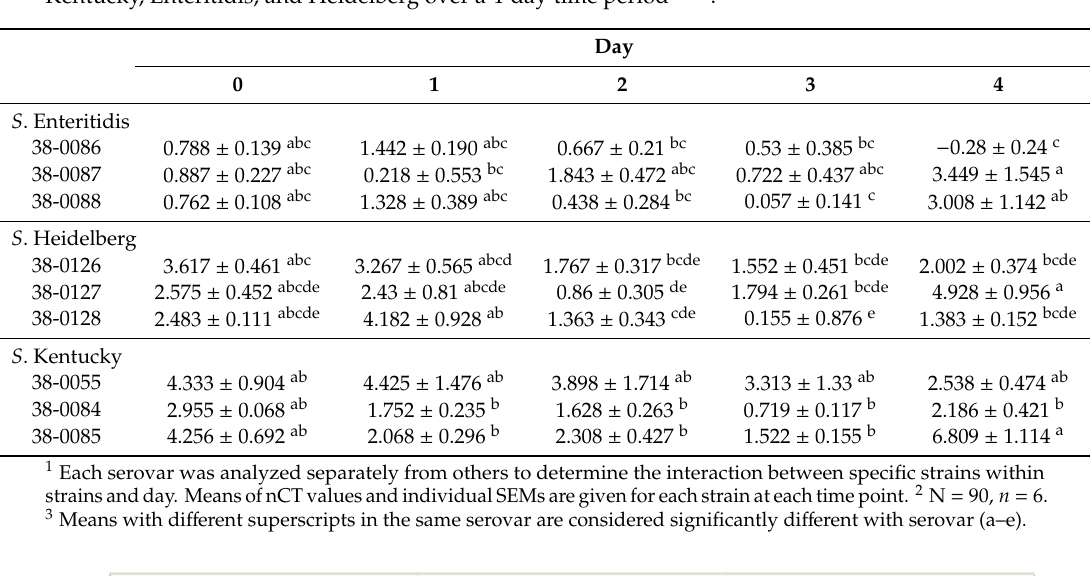
Table 2. Changes in expression of the gene csgD from planktonic cells used to form pellicles in Salmonella Kentucky, Enteritidis, and Heidelberg over a 4-day time period 1,2,3 .